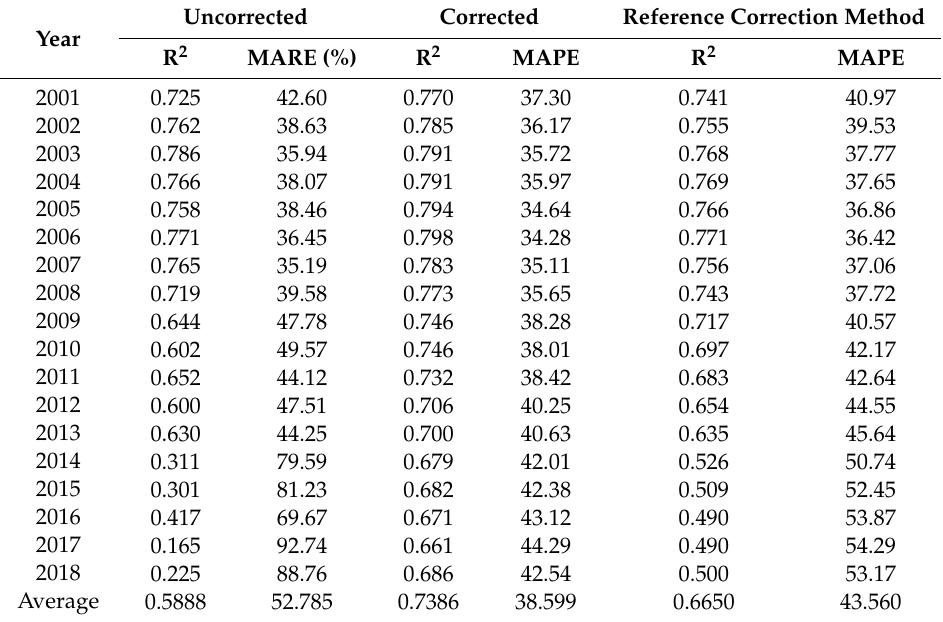
Table 7. Model fitting precision values between TNL and GDP using power function model in provincial